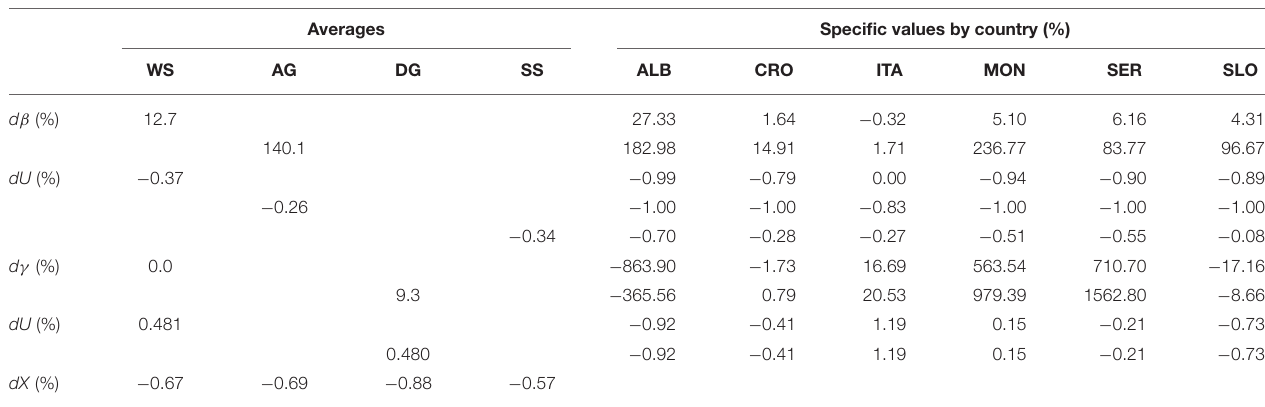
TABLE 8 | Adriatic Sea: non-cooperative solutions. Averages Specific values by country